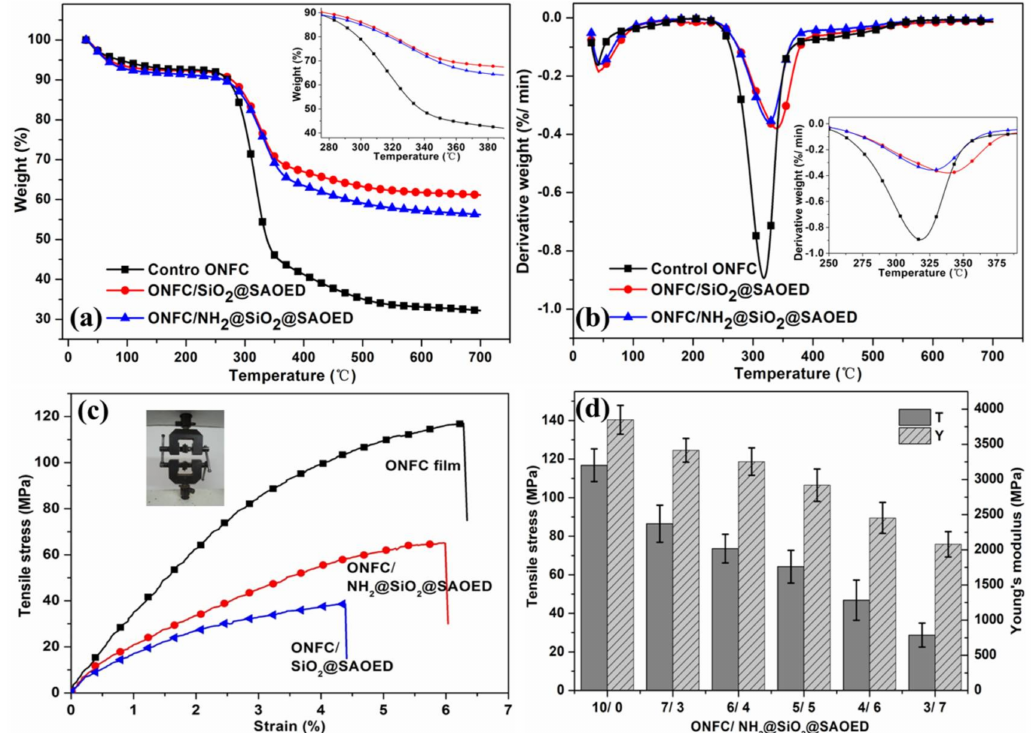
Figure 7. Thermal analysis and tensile strength of the ONFC luminescent films: ( a ) TG and ( b ) DTG curves of luminescent composite films with different modified SAOED phosphors (mass ratio = 1/1) compared with control ONFC film; ( c ) Stress-strain curves of tensile test results of control ONFC film, composite films with different modified SAOED phosphors (mass ratio = 1/1); ( d ) Tensile strength of ONFC/NH 2 @SiO 2 @SAOED luminescent films with different mass